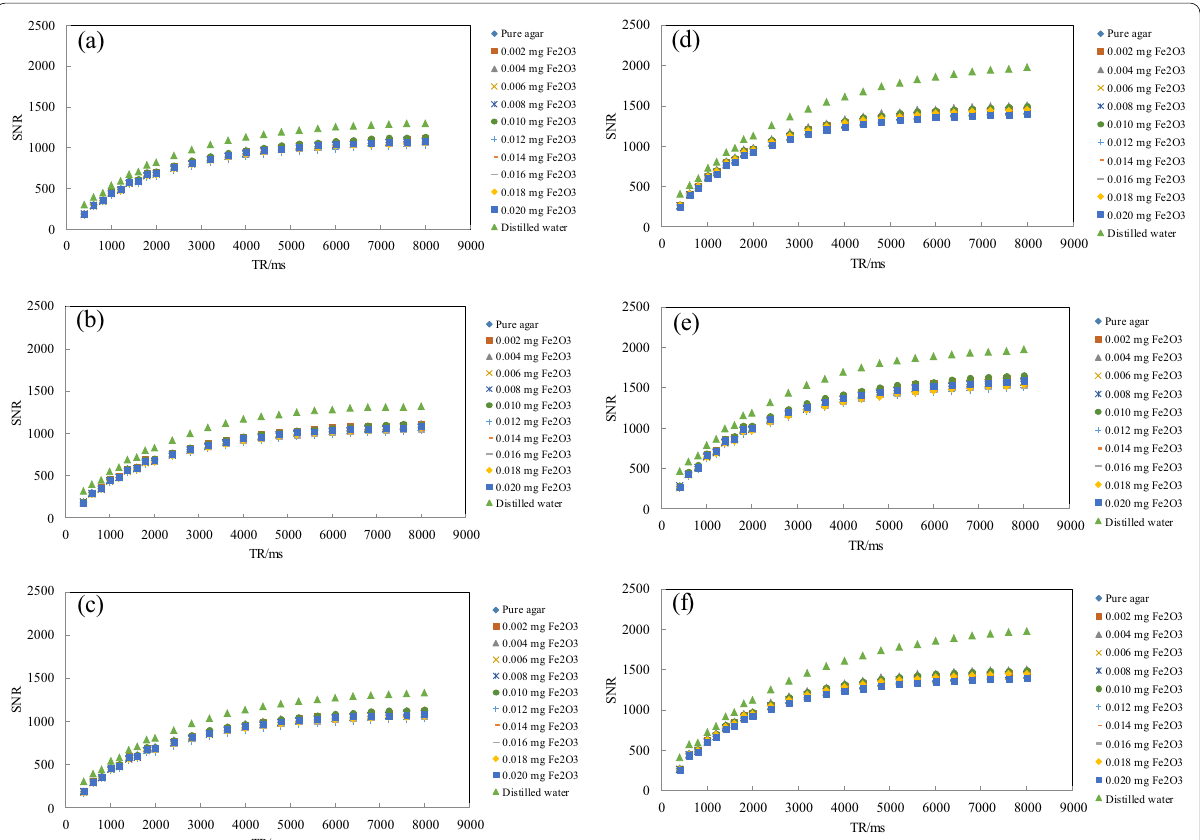
Fig. 1 T1 curves obtained from the phantoms at TP1 (left) by using a 1 ROI, b 3 ROIs and c 25 ROIs, and at TP2 (right) by using d 1 ROI, e 3 ROIs